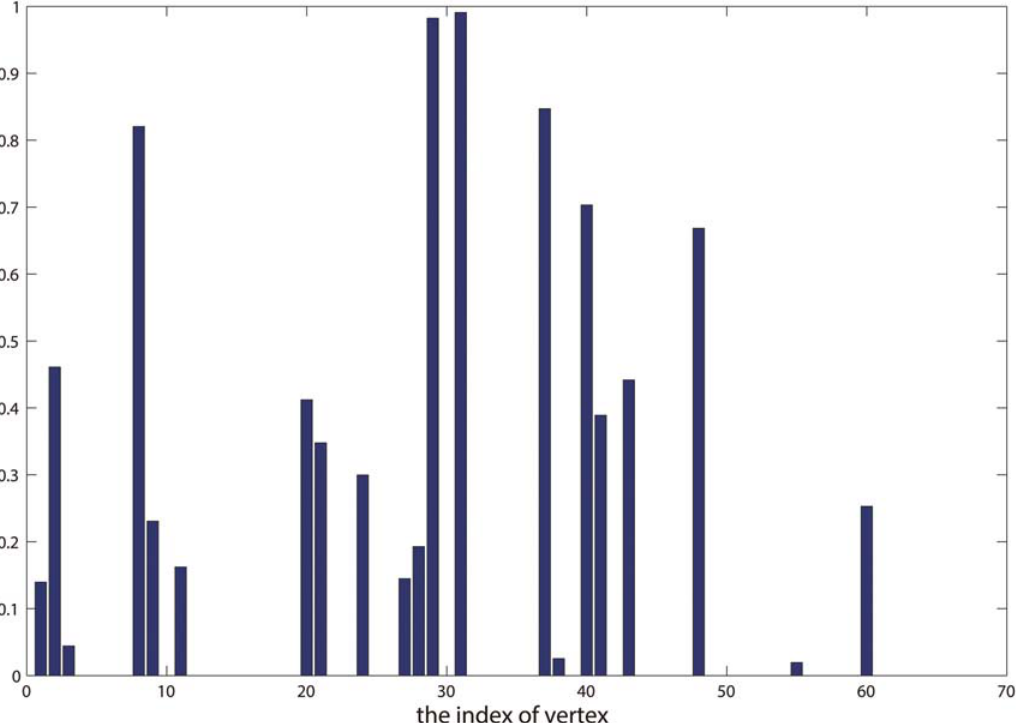
Fig 8. Four communities detected by our approach on dolphins network. Here different shapes represent the ground-truth communities, and different colors represent the communities obtained by our approach. Especially, the overlapping vertices are shown by pie vertices.